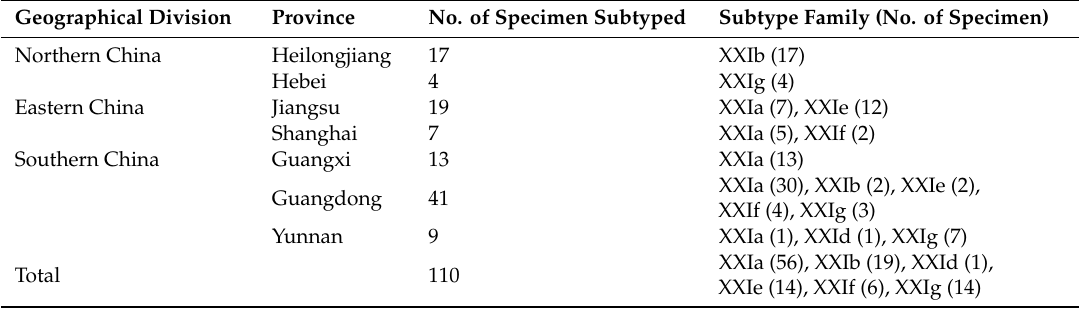
Table 3. Distribution of Cryptosporidium ryanae subtype families at the gp60 locus in dairy cattle by geographical